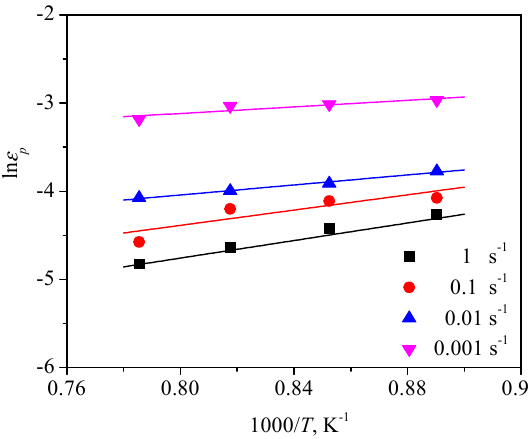
ε ) and strain rate ( ε  ). . ε ).